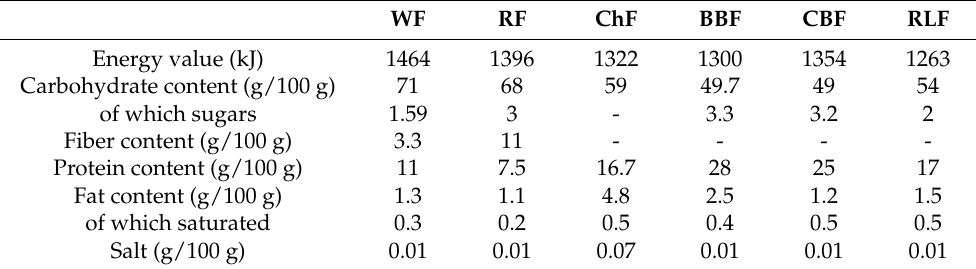
Table 1. Quality parameters of commercial flours.